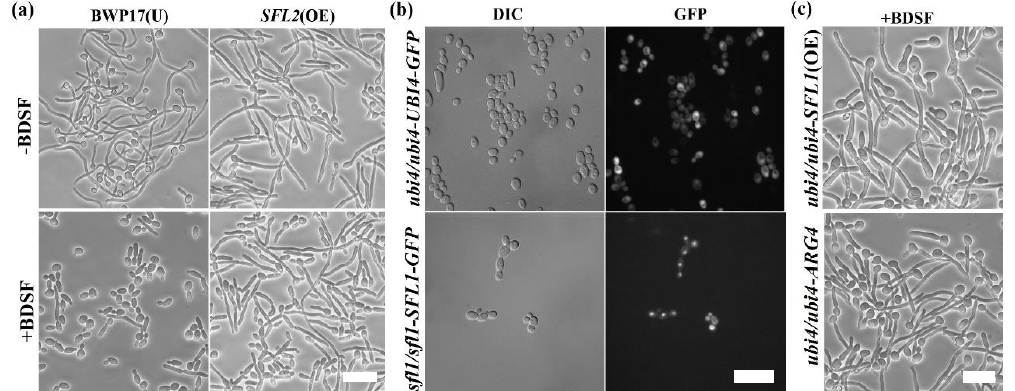
Figure 4. ( a ) Overexpression (OE) of SFL2 leads to BDSF resistance. ( b ) Subcellular localization of SFL1-GFP and UBI4-GFP in C. albicans cells. ( c ) Overexpression of SFL1 in ubi4∆/∆ mutant remained insensitive to BDSF. Hyphal induction was performed with the addition of 5% FBS and maintained at 37 ◦ C for 4 h in the presence or absence of 150 µ M BDSF. Bars, 15 µ